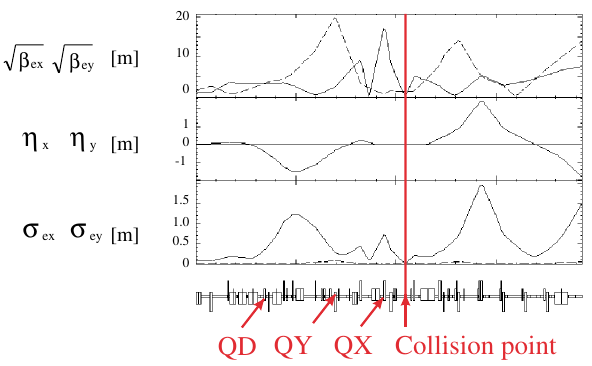
FIG. 7. (Color) Designed optics calculated by SAD .